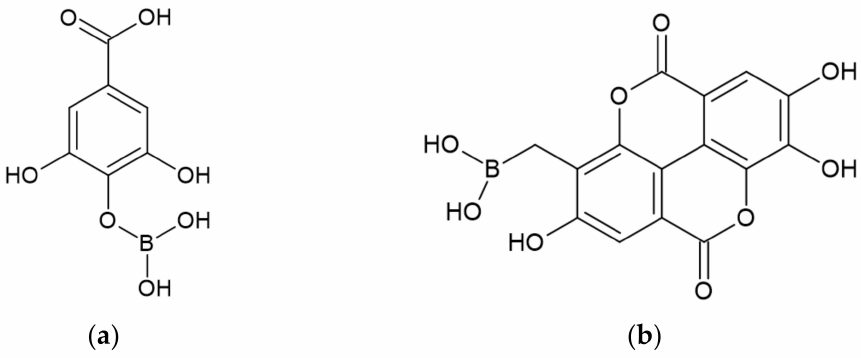
Figure 18. Putative structures of derivatives of acids [41]: ( a ) gallic acid derivative (GAD); ( b ) ellagic acid derivative